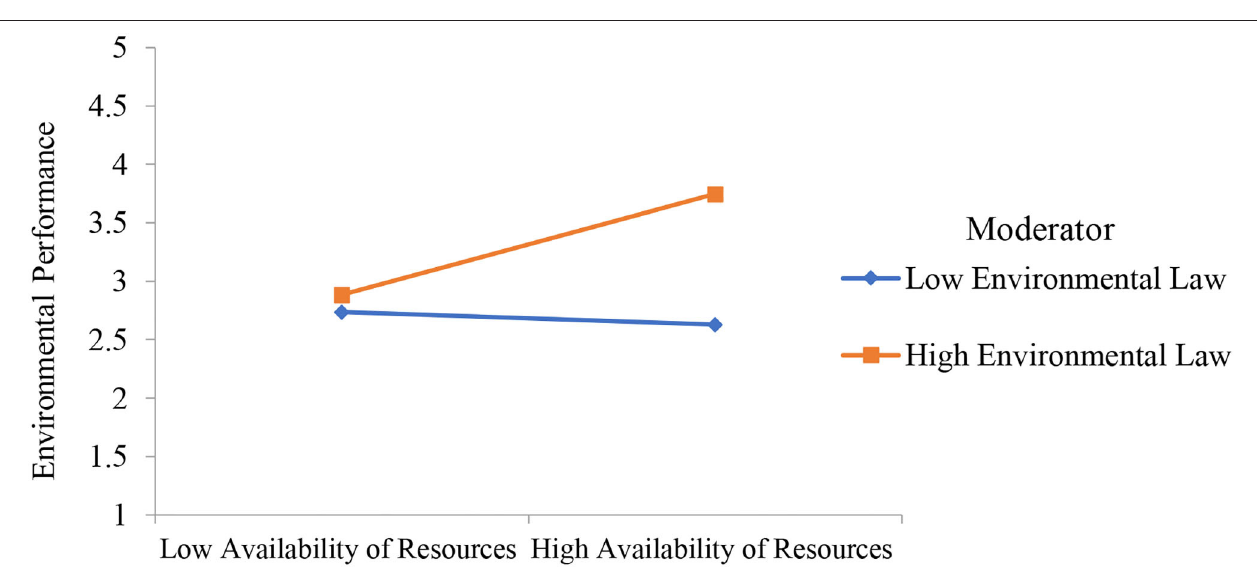
FIGURE 6 | Moderation effect of environmental law strengthens the relationship between availability of resources and environmental